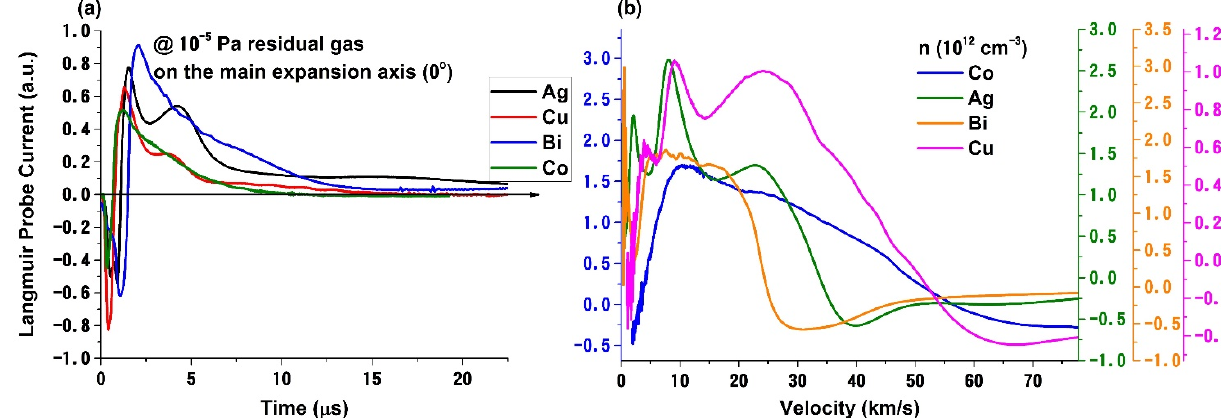
Figure 2. Un-biased probe current for several metallic plasmas ( a ) and the corresponding charge density distribution with expansion velocities ( b ).